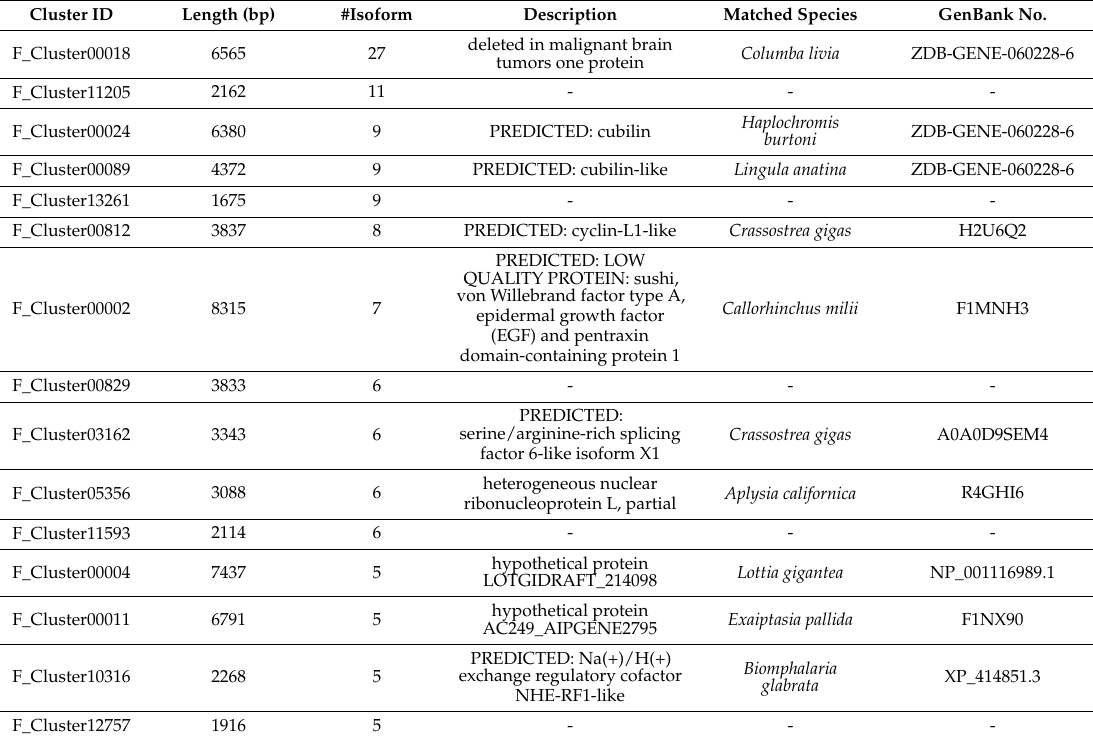
Table 4. List of top-ranked genes containing over five isoforms in the female abalone.